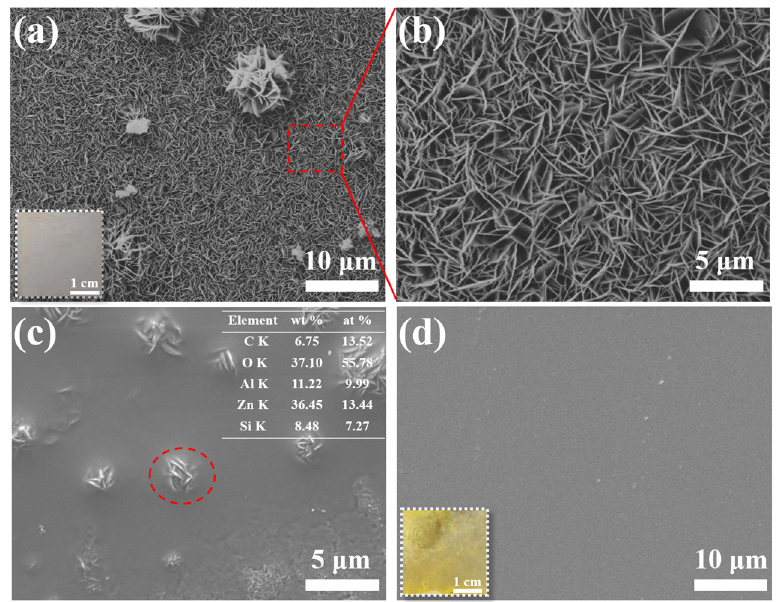
Figure 1. SEM images of ( a , b ) LDH ‐ N film, ( c ) LDH ‐ V/SG ‐ Ce film (one layer of SG, red dotted circle for EDS detection) and ( d ) LDH ‐ V/SG ‐ Ce film (two layers of